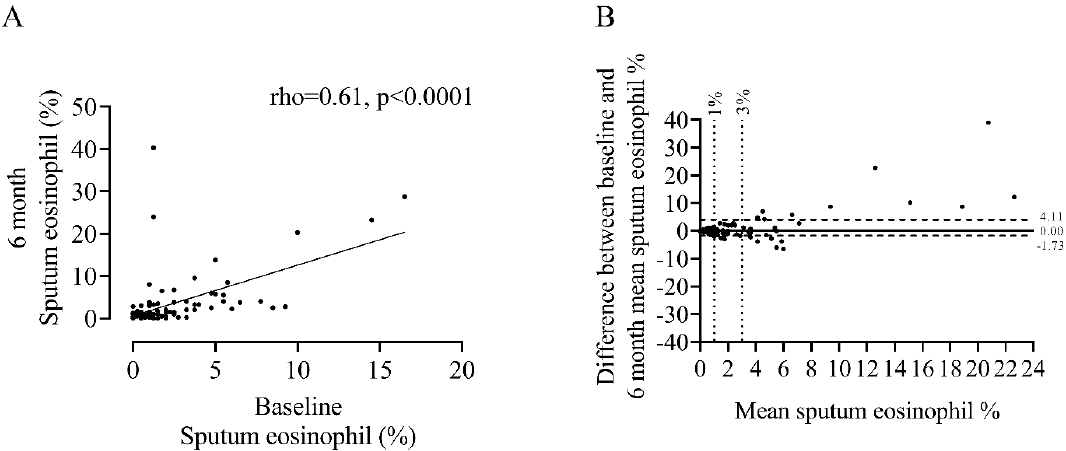
Figure 1. Association between baseline and 6 month measures of sputum eosinophil % ( A ) and Bland–Altman plot of the difference versus the mean of two repeat measurements ( B ). Horizontal solid black line in panel B represents the median difference, horizontal dashed black lines represent the 90th percentile and the vertical dotted lines represent thresholds of 1 and 3% sputum eosinophil indicative of eosinophil LOW and eosinophil HIGH groups respectively. n = 100.